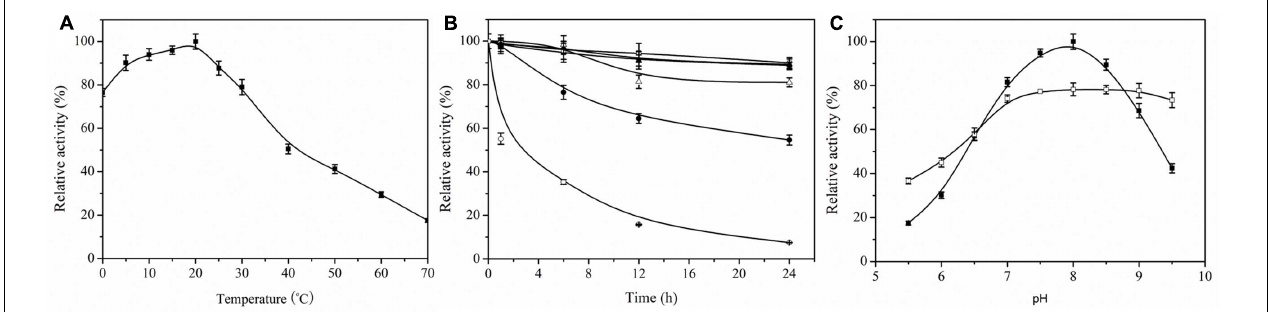
FIGURE 5 | Effect of temperature and pH on activity and stability of recombinant Aii810. Effect of temperature on activity (A) and stability (B) of recombinant Aii810. The purified enzyme was pre-incubated at 0 ◦ C ( (cid:4) ), 10 ◦ C ( (cid:3) ), 20 ◦ C ( (cid:78) ), 35 ◦ C ( (cid:52) ), 40 ◦ C ( stability ( (cid:3) ) of recombinant Aii810 (C) . The purified enzyme was pre-incubated in different buffers for 12 h at 0 ◦ C. Data points are the average of triplicate measurements, and error bars represent the standard deviation.